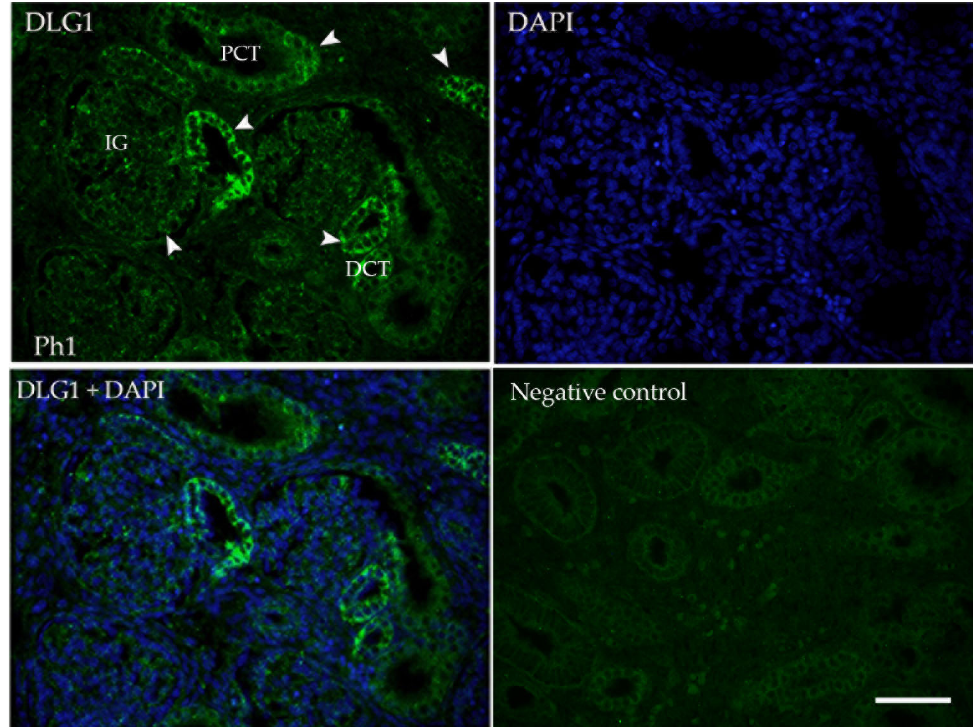
Figure 2. Immunofluorescence staining of human fetal kidneys (Ph1) with the DLG1 (green) and DAPI nuclear staining. Expression of DLG1 is found (arrows) in immature glomeruli (IG), proximal convoluted tubules (PCT), and distal convoluted tubules (DCT), while surrounding mesenchyme is negative. Scale bar is 50 μ m.